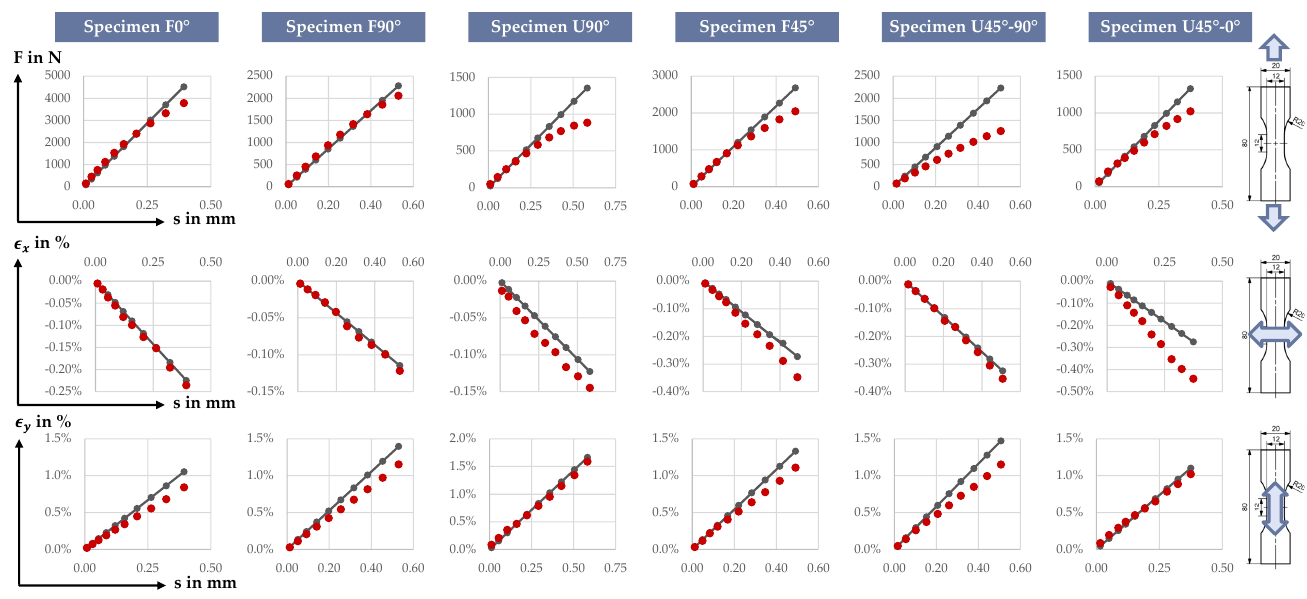
Figure 12. Fitting of force-displacement, transverse strain-displacement, and longitudinal strain simulation results (grey lines) to experimental results (ten red points each, identified above).